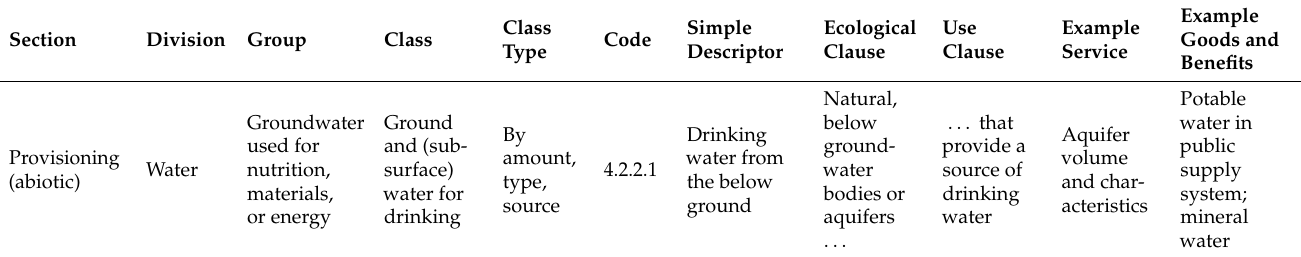
Table 1. Excerpt from CICES v5.1 illustrating the hierarchical structure used to describe services.